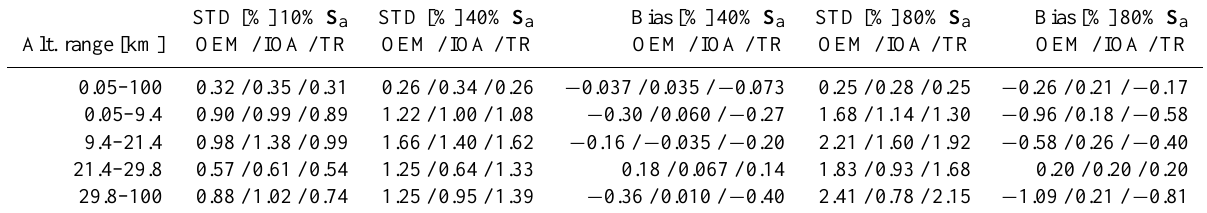
Table 6. Impact of different choices of S a on the O 3 total and partial columns retrieved with the OEM, IOA and TR, for the 2007 campaign data at Ile de La R´eunion: mean daily relative STD and mean relative biases with respect to the retrieval with 10% S a .